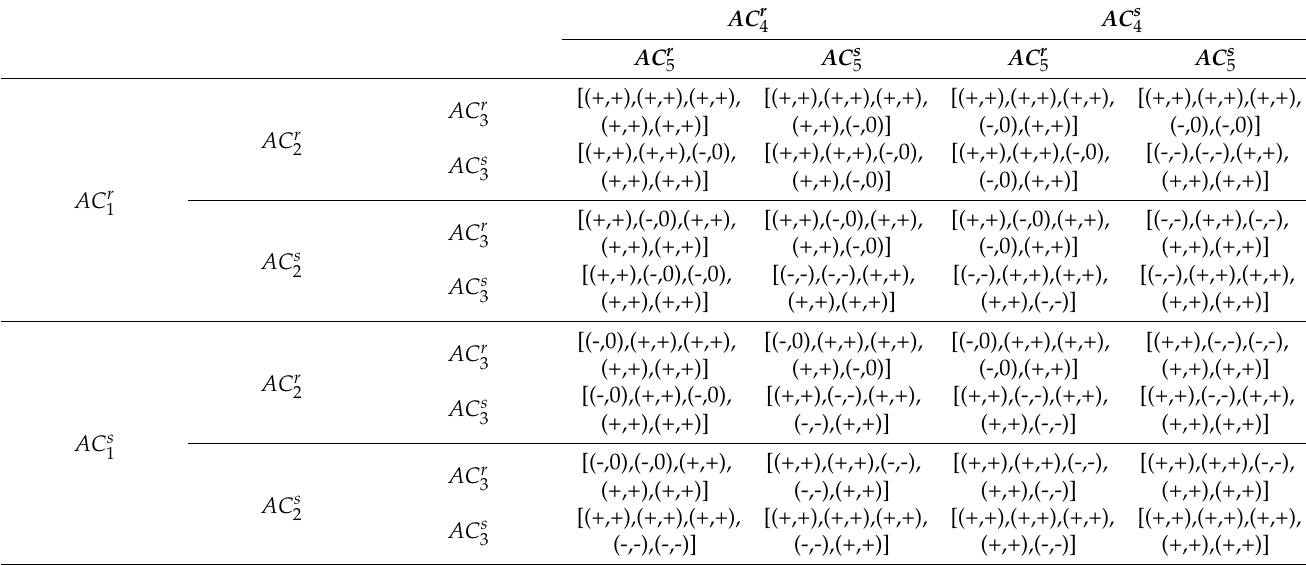
Table 1. Five-player game and incentive